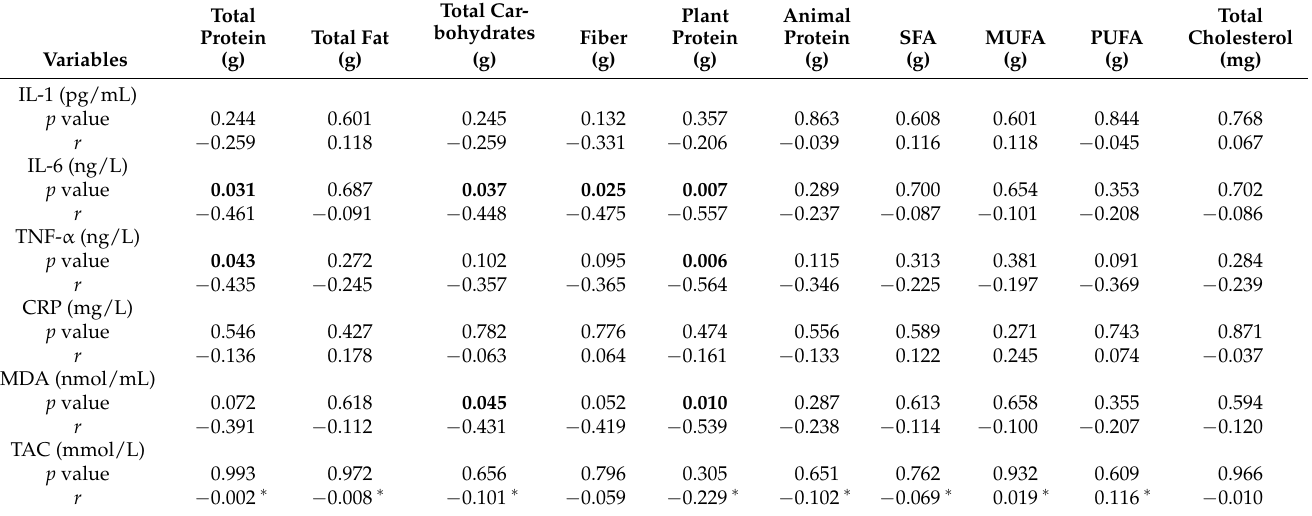
Table 3. Spearman and Pearson’s correlations among Inflammatory and Oxidative Stress markers and macronutrient intakes in Adolescent Girls with PCOS in the Ov/Ob group.